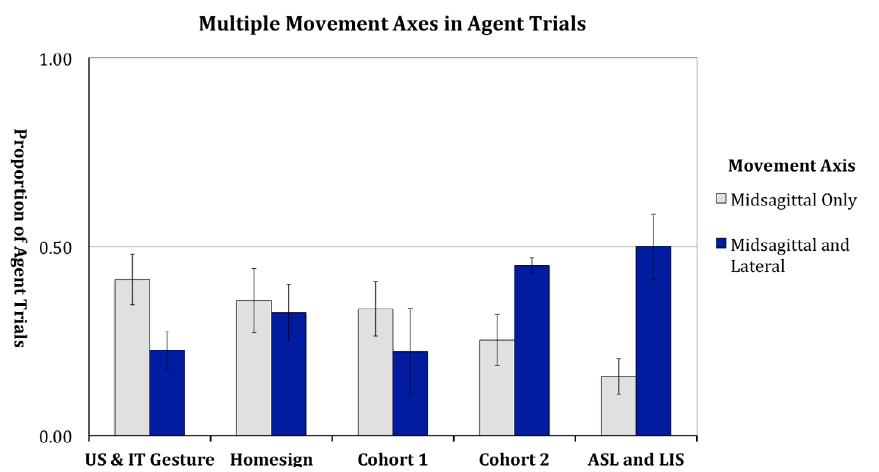
Fig. 5. The proportion of responses that contained only a midsagittal movement (gray bars) or both midsagittal and lateral movements (blue bars) produced by Silent Gesturers, Homesigners, NSL Cohort 1 signers, NSL Cohort 2 signers, and signers of ASL and LIS in descriptions of Agent vignettes. Error bars indicate standard